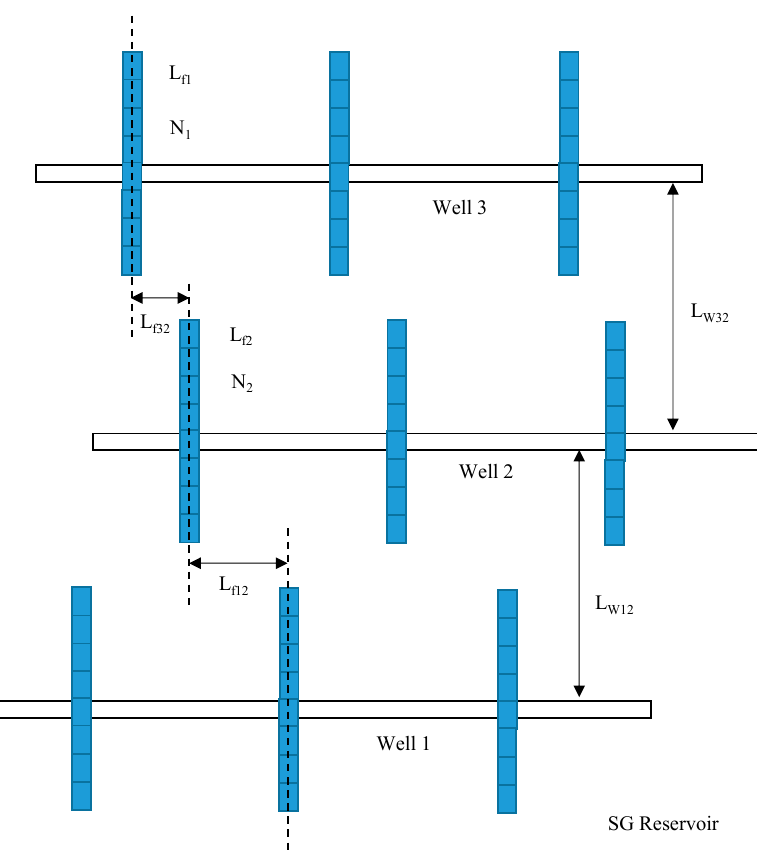
Figure 4. Grid discretion of multi-well pad production (MWPs) scheme.